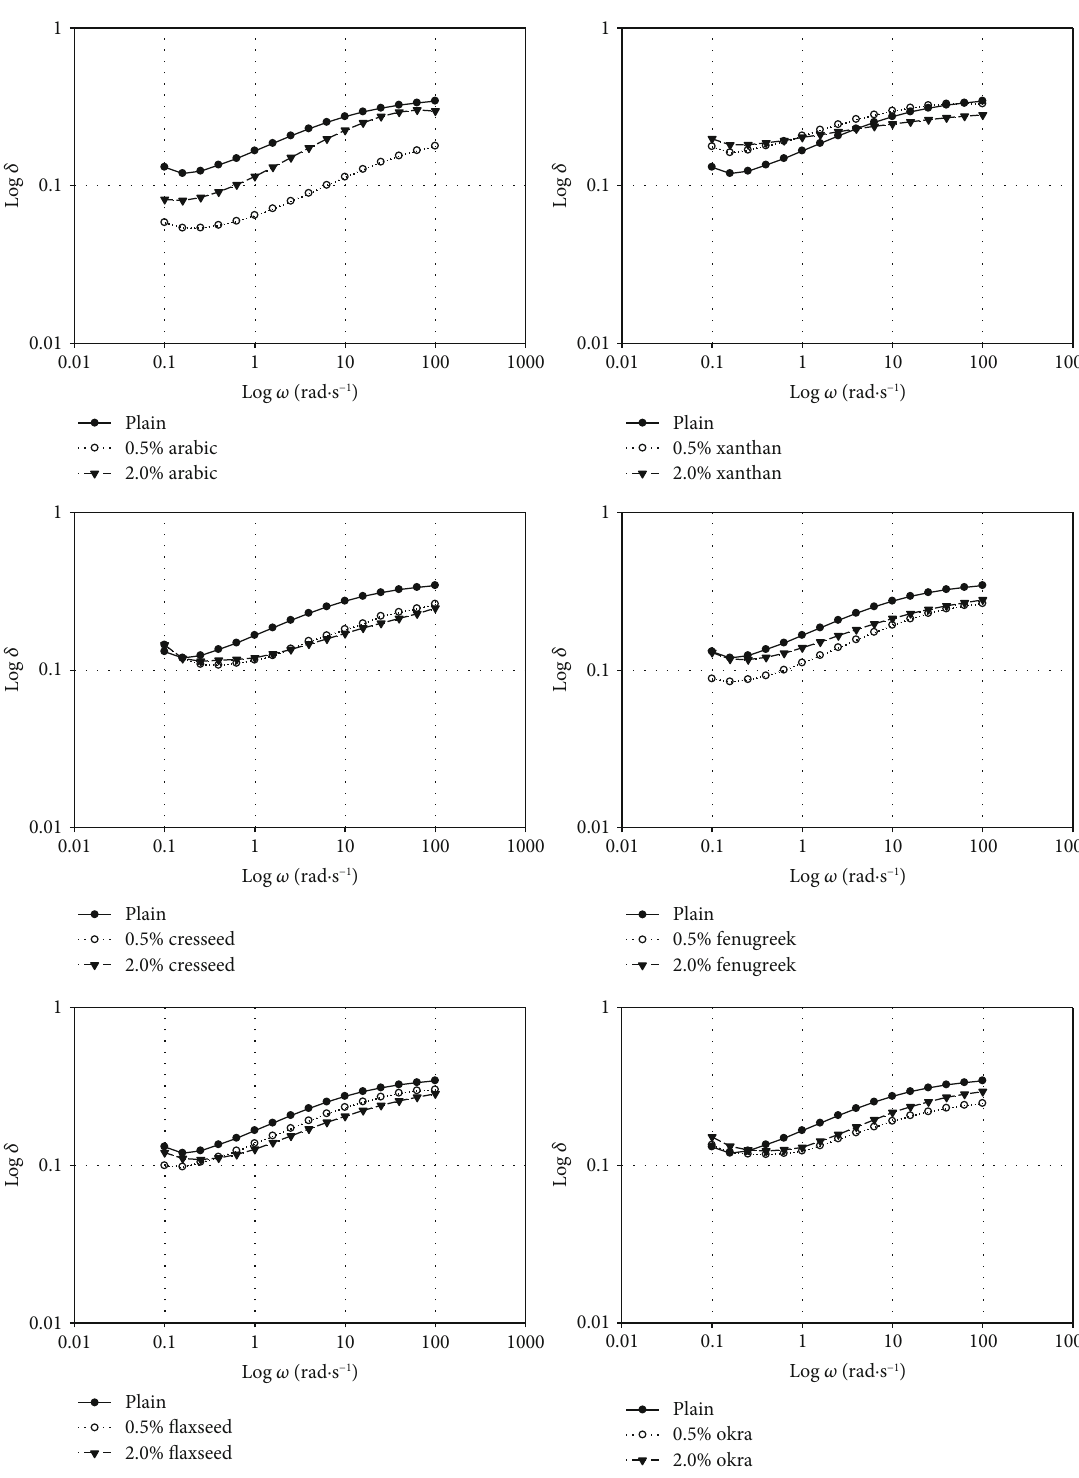
Figure 2: Plots of log δ versus log ω of sweet potato starch gum blends at di ff erent gum